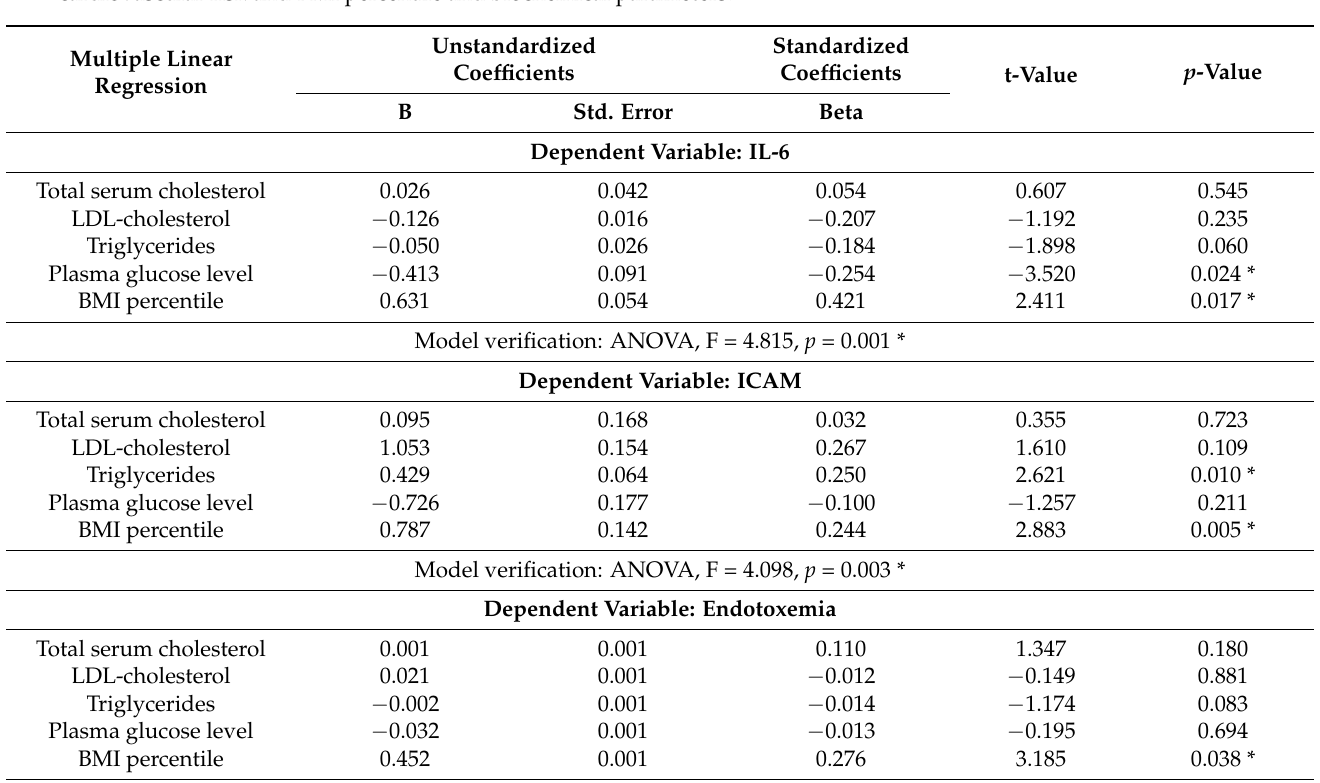
Figure 1. The regression line in the correlation of IL-6 and ICAM values. Table 3. The coefficients of multiple linear regression regarding the correlations between early inflammatory markers of cardiovascular risk and BMI percentile and biochemical